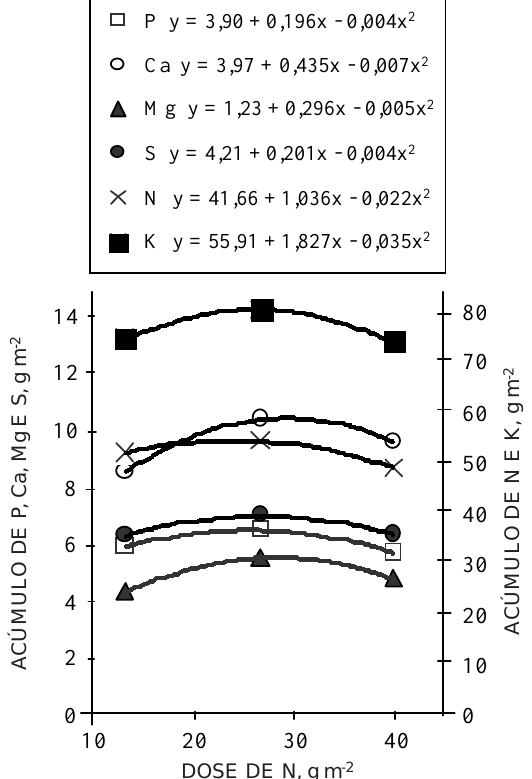
Figura 1. Acúmulo de nutrientes pela parte aérea do pimentão (caule, folhas e frutos), consi- derando a aplicação de N no solo, na dose de K de 5,5 g m -2 , após 34 semanas de cultivo em ambiente